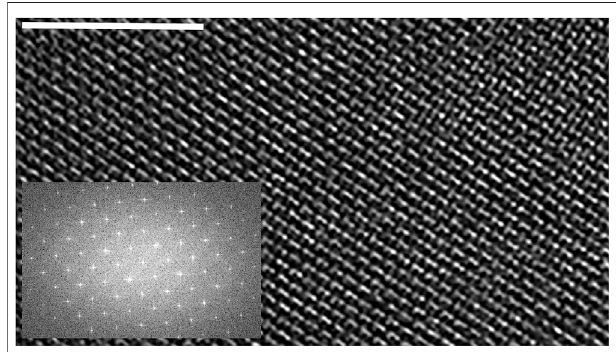
FIGURE 3 | HR-TEM image from a 20-nm-thick TmBiIG/sGGG cross- sectional structure.Thewhitescalebar corresponds to5 nm.Insetshowsthe FFT from the image.